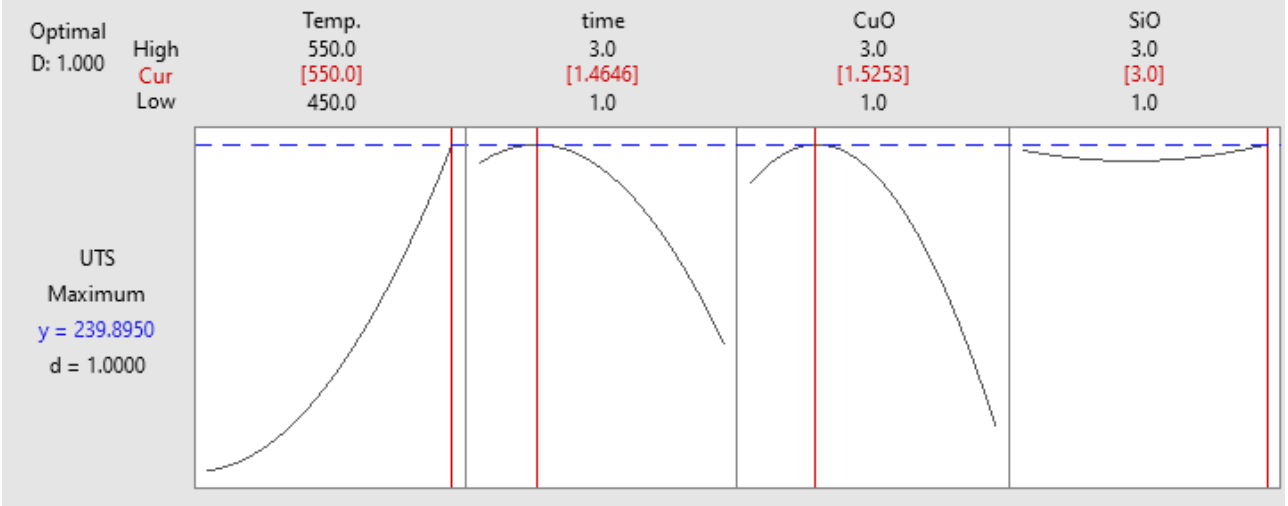
Figure 8. Optimisation plot for UTS.